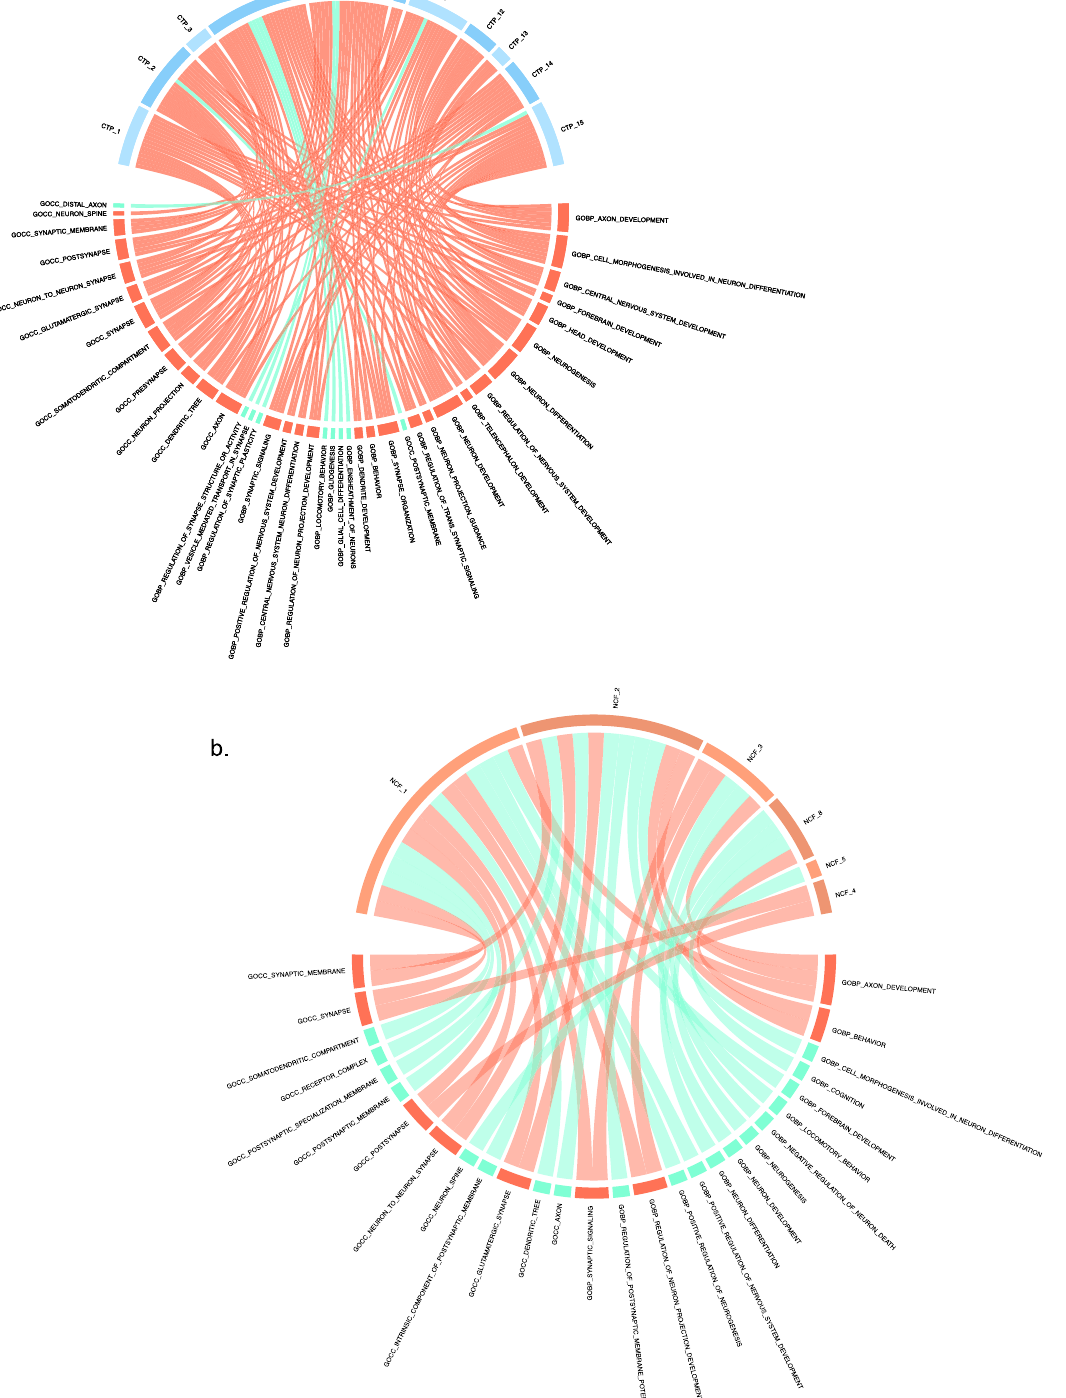
Fig. 4 | Unique and overlapping gene sets within cognitive task performance and non-cognitive factor meta-loci. CTP cognitive task performance. NCF non- cognitive factor. a Circle plot for general cognitive ability and notable meta-loci. b Circle plot for non-cognitive skills and notable meta-loci. Turquoise lines within